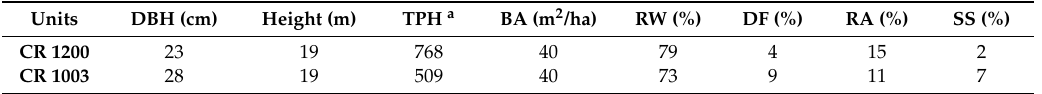
Table 2. Post-thinning stand characteristics of DBH, height, trees per hectare (TPH), basal area (BA), and species distribution (percent of